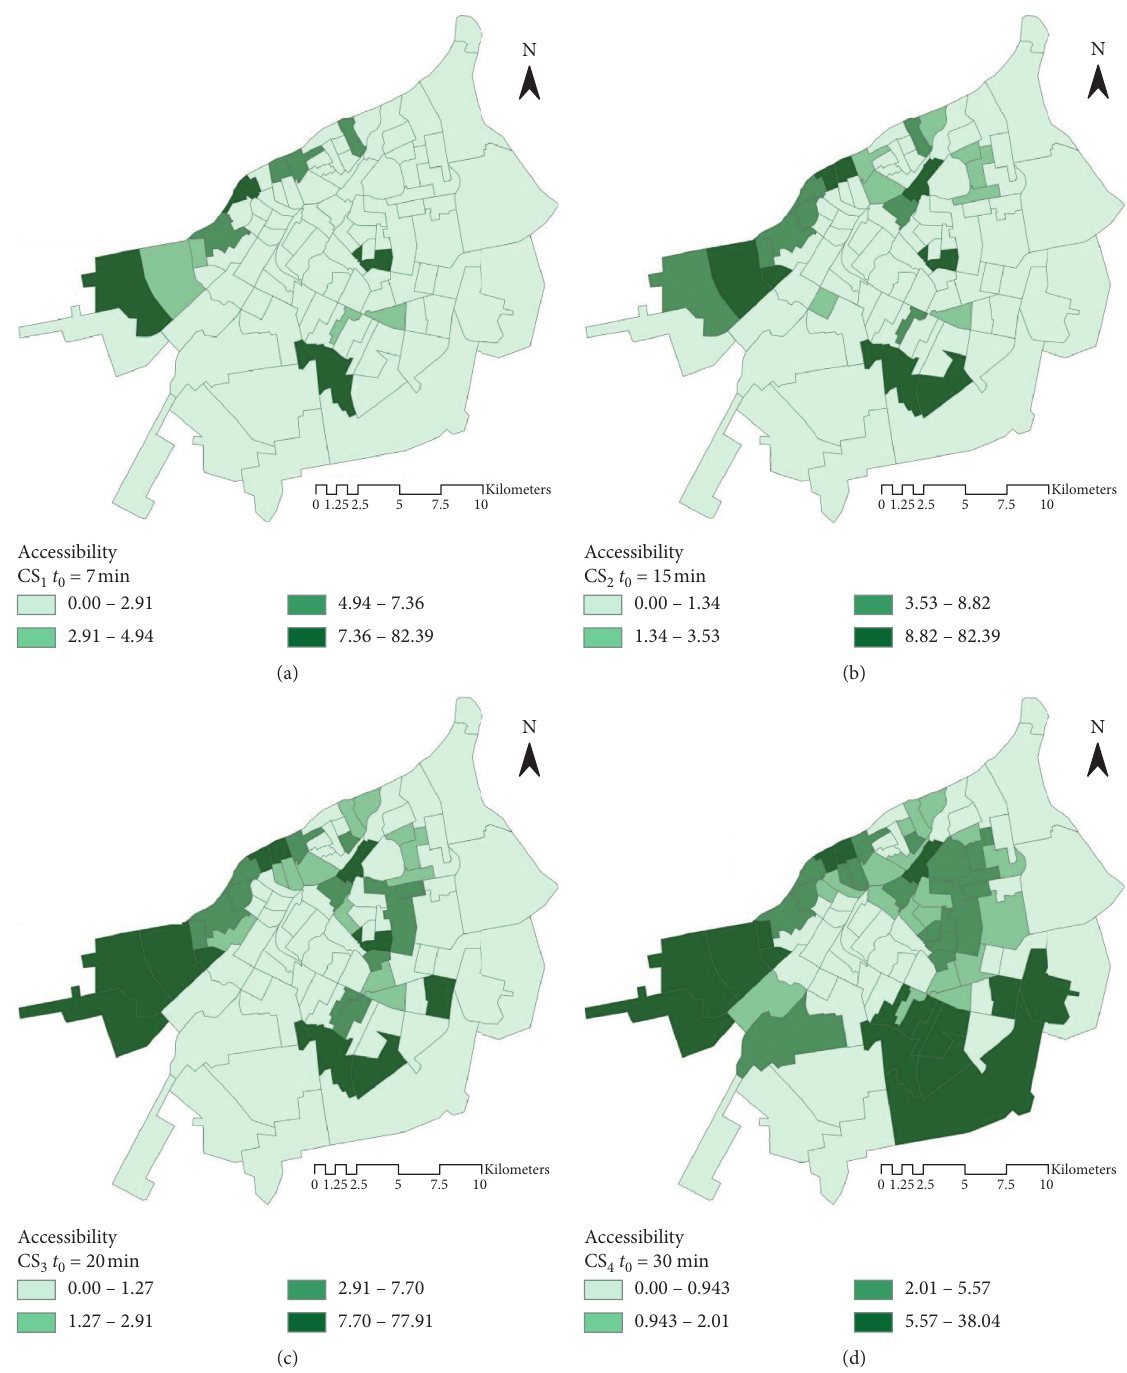
Figure 3: Spatial accessibility to urban green spaces in Harbin ( t